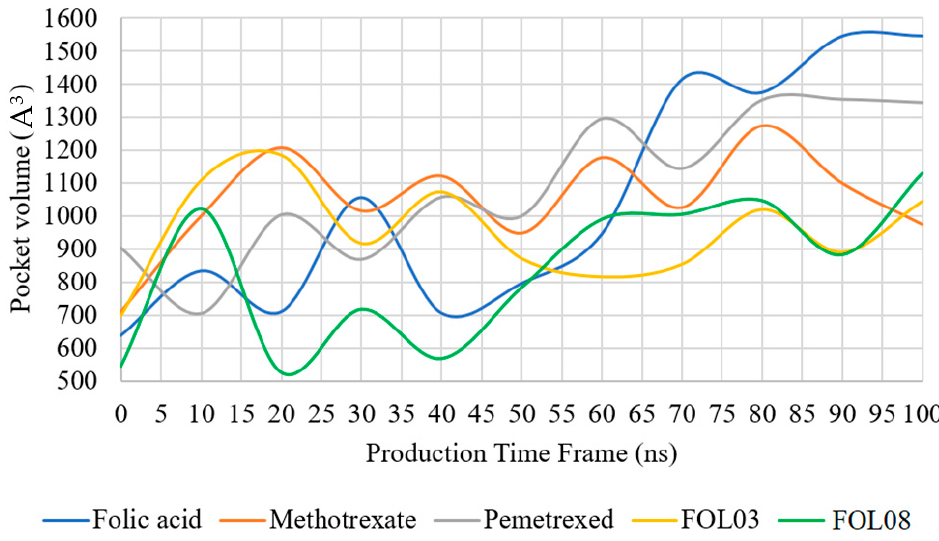
Figure 15. The volume of the FR α (PDB: 4LRH) binding pocket interacting with ligands (FA, MTX, PTX, FOL03, and FOL08) as a function of time during MD simulation.